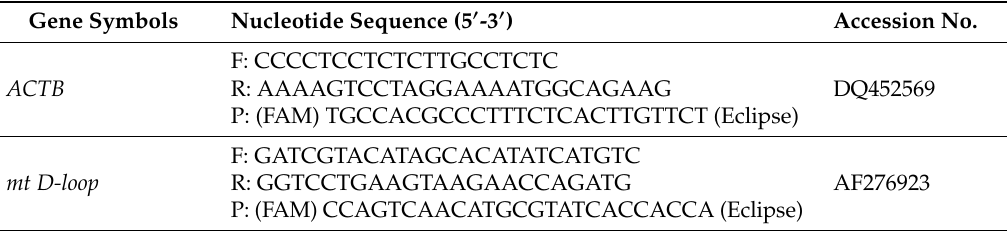
Table 2. Primers and probes sequences used for determination of mitochondrial DNA (mtDNA) content. Gene Symbols Nucleotide Sequence (5 (cid:48) -3 (cid:48) ) Accession